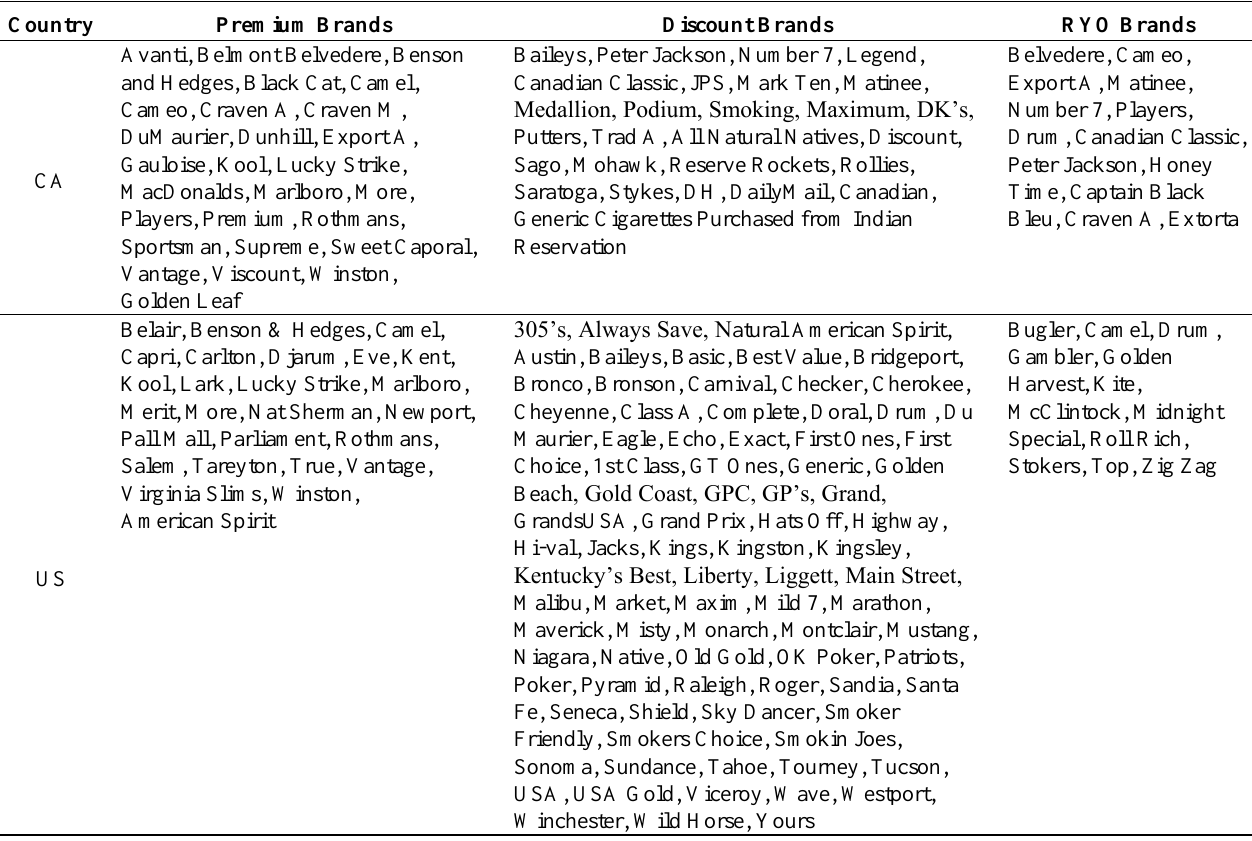
Table 2. Categorized List of Premium, Discount, and Roll Your Own (RYO) Brands by Country, wave 5 of the ITC-4 Survey